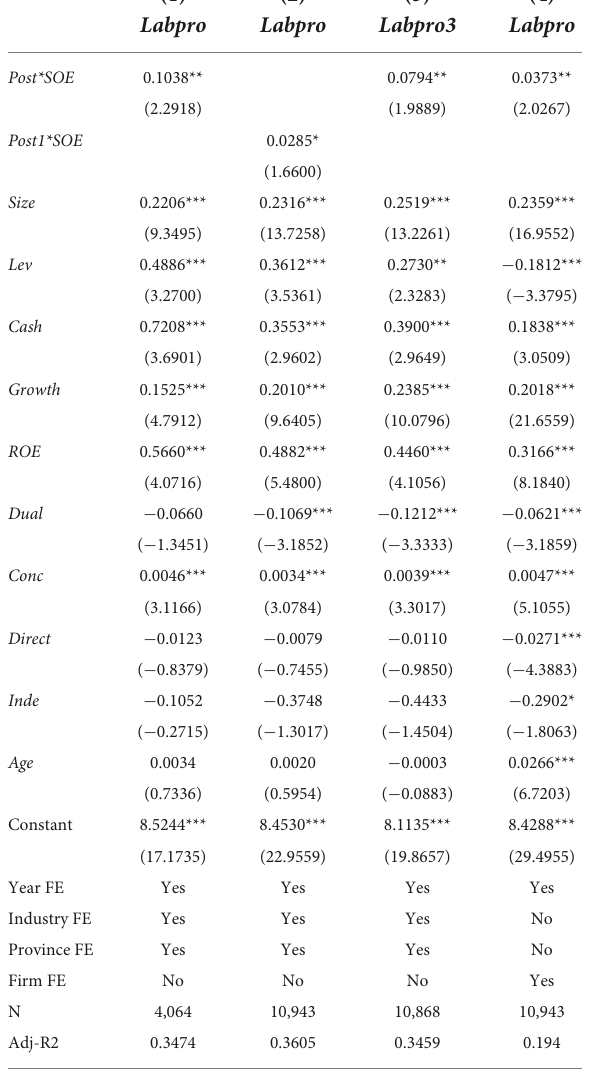
TABLE 5 Other robustness test